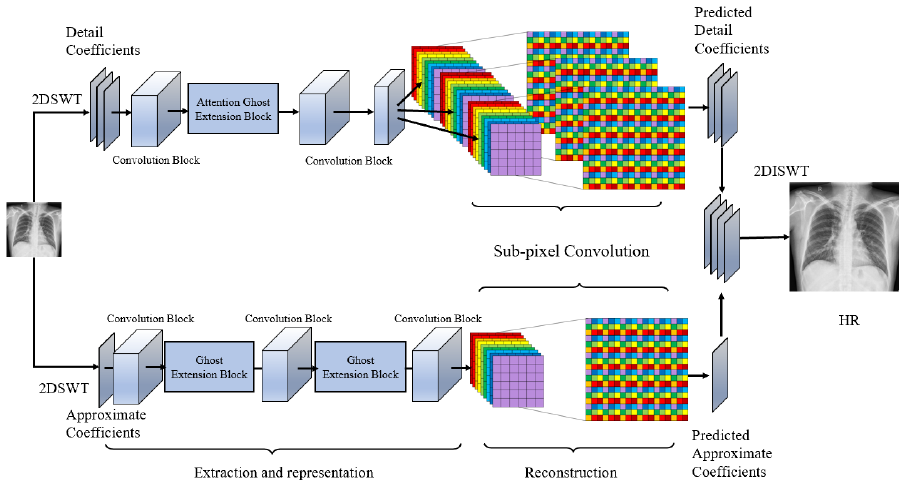
Figure 5. The network structure of WFSAN. The inputs are separated into approximate and detail sub-band coefficients of low-resolution image. The network output is the combination of approximate and detail sub-band coefficients of the predicting